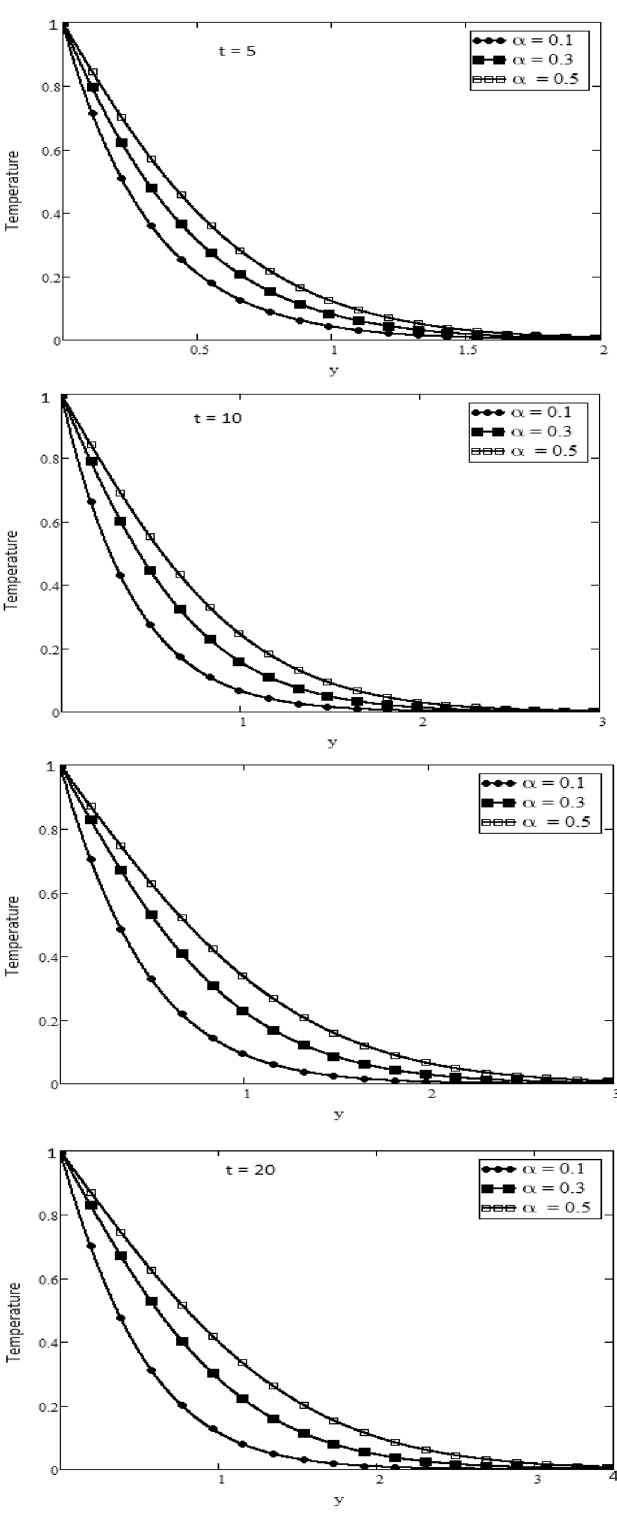
Figure 1. Temperature